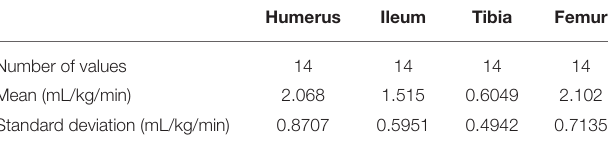
TABLE 6 | Pressure infusion rates.